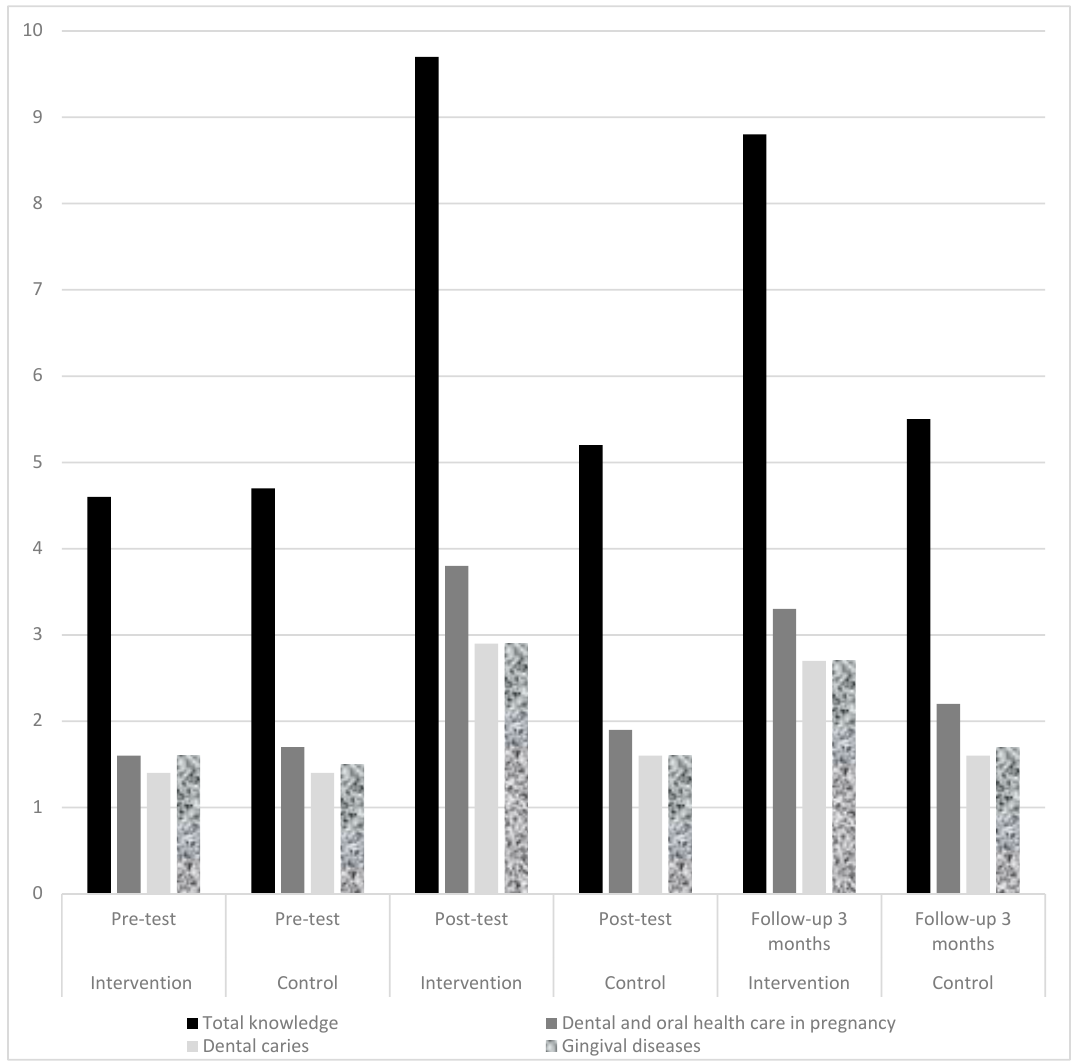
Figure 2. Mean knowledge scores in both intervention, and control groups at pre-test, post-test and follow-up 3 months.